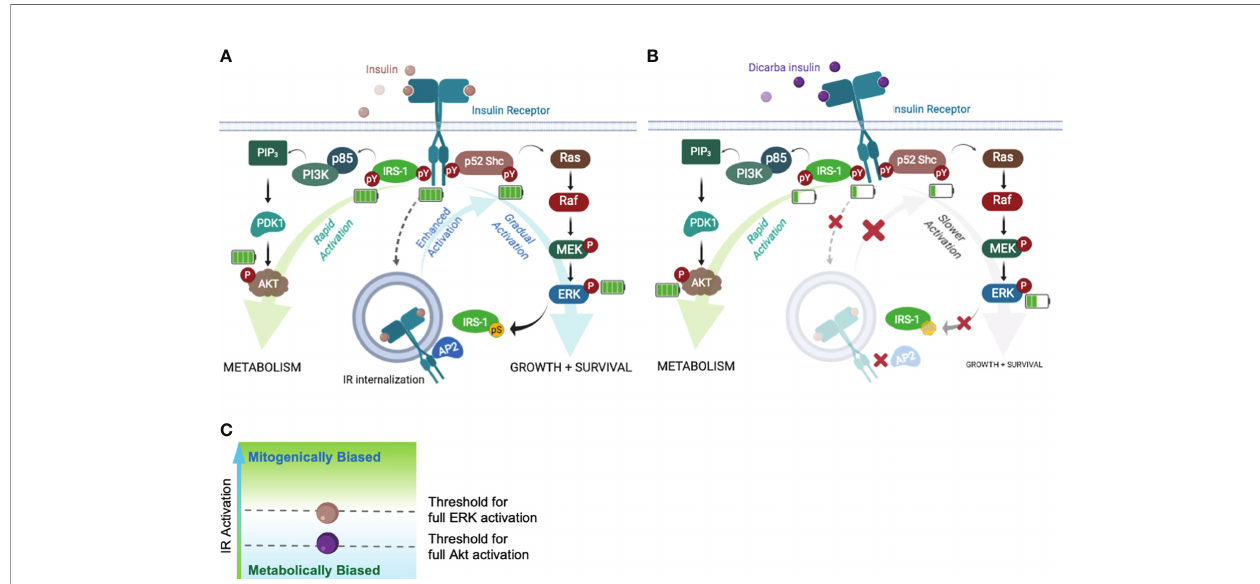
FIGURE 7 | Akt and ERK requires different IR activation thresholds to achieve full activation that in fl uence the fate of biological outputs. Schematic of the Akt-PI3K and ERK-MAPK signalling pathways following ligand binding. Increased/decreased green bars in battery symbol represent an increase or decrease in levels of phosphorylation. (A) Insulin binding to the IR with full activation of pathways leading to metabolism, growth and survival. (B) Dicarba insulin binding to the IR with decreased activation of the IR, IRS-1, Shc and ERK1/2 resulting in impaired feedback to IRS-1 and decreased IR internalization (decreased growth and survival). Akt signalling continues equivalent to the response to insulin (C) Schematic indicating the threshold levels of IR activation that are required for full ERK and/or full Akt activation (mitogenically or metabolically